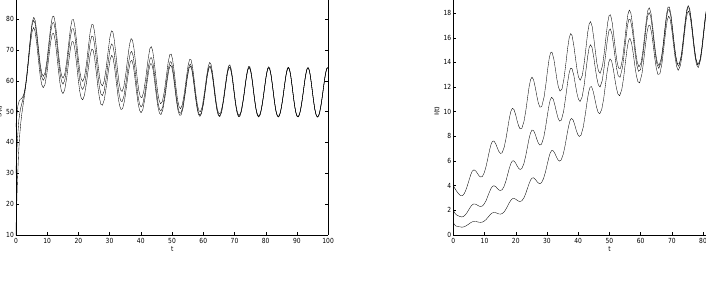
Figure 2. Trajectories of I(t) for dif- ferent initial conditions.